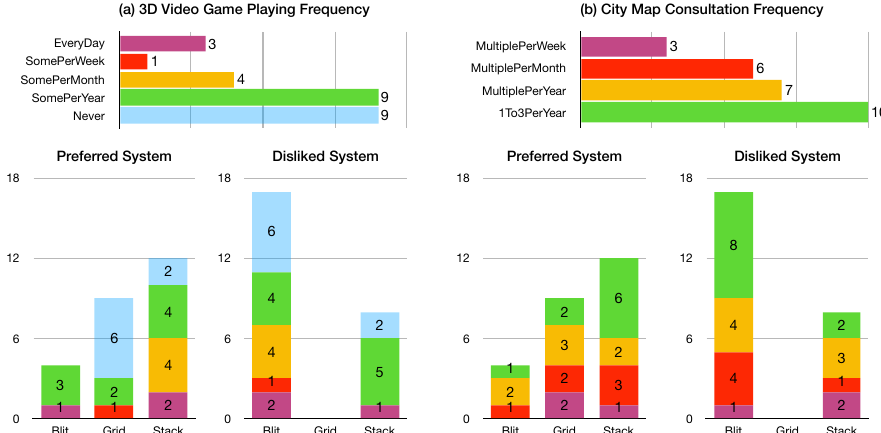
Figure 7. Left ( a ): the numbers of participants who play 3D-based video games at different frequencies, and their distribution among those who “preferred” and “disliked” each system, according to the measurement in Figure 6; right ( b ): same for the frequency of consulting city